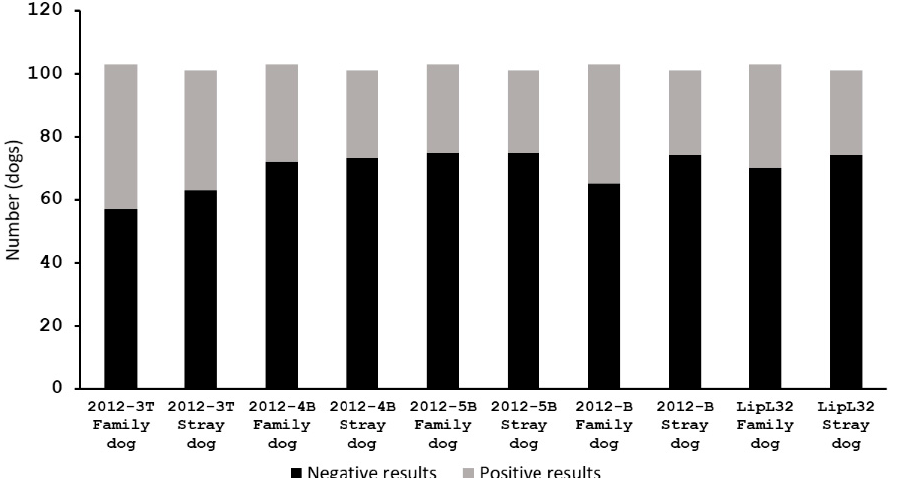
Figure 5. The numbers of dogs that gave positive and negative results from peptide-based ELISA and LipL32 ELISA. The associations between types of dogs (family and stray dogs) and leptospirosis (positive and negative results) were determined using chi-squared test. All data gave p -value > 0.05, meaning that leptospirosis was not correlated to the type of dog.